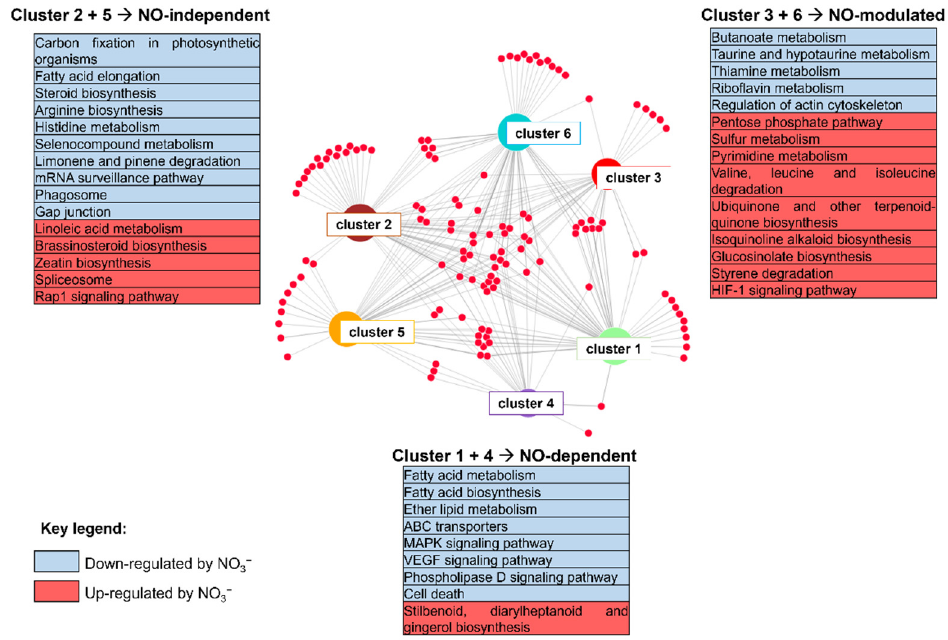
Figure 4. Pathway assignment based on KEGG mapper reconstruction of DEGs specific among the six clusters. Cluster 1, DEGs down-regulated by nitrate provision and NO-dependent; cluster 2, DEGs down-regulated by nitrate and NO-independent; cluster 3, DEGs down-regulated by nitrate and NO-modulated; cluster 4, DEGs up-regulated by nitrate provision and NO-dependent; cluster 5, genes up-regulated by nitrate provision and NO-independent; cluster 6, DEGs up-regulated by nitrate and NO-modulated.